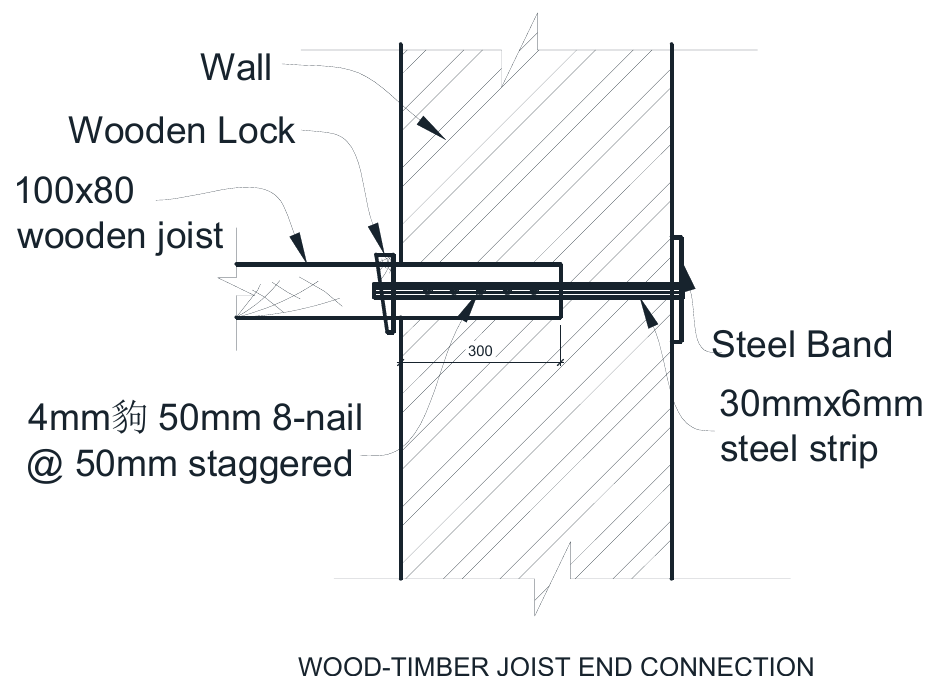
Figure 13. Details of timber joist end connection.